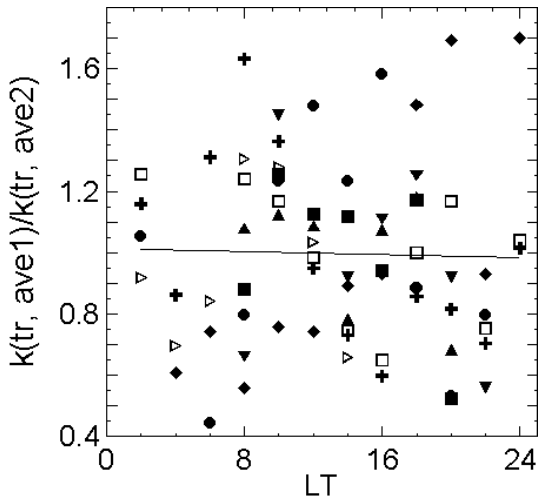
Fig. 5. The ratio of the nongeomagnetic trend k(tr, ave 1 ) de- rived for each LT moment to the daily mean value for this par- ticular station k(tr, ave 2 ) versus local time. Stations used: Dik- son (dots), Loparskaya (diamonds), Lycksele (closed rectangles), Kiruna (closed triangles), Leningrad (open rectangles), Uppsala (crosses), Salekhard (inverted triangles), and Sodankyla (open tri-